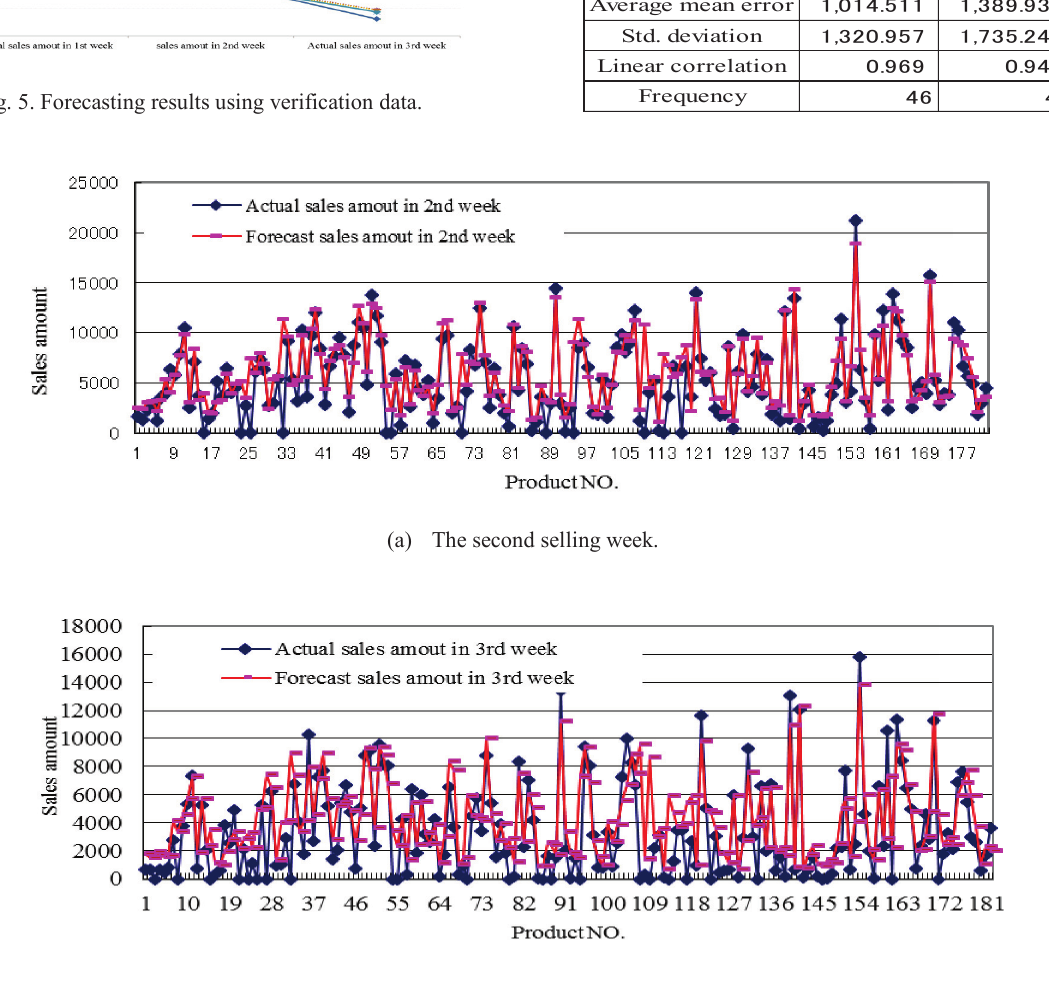
Fig. 6. Forecasting result using learning